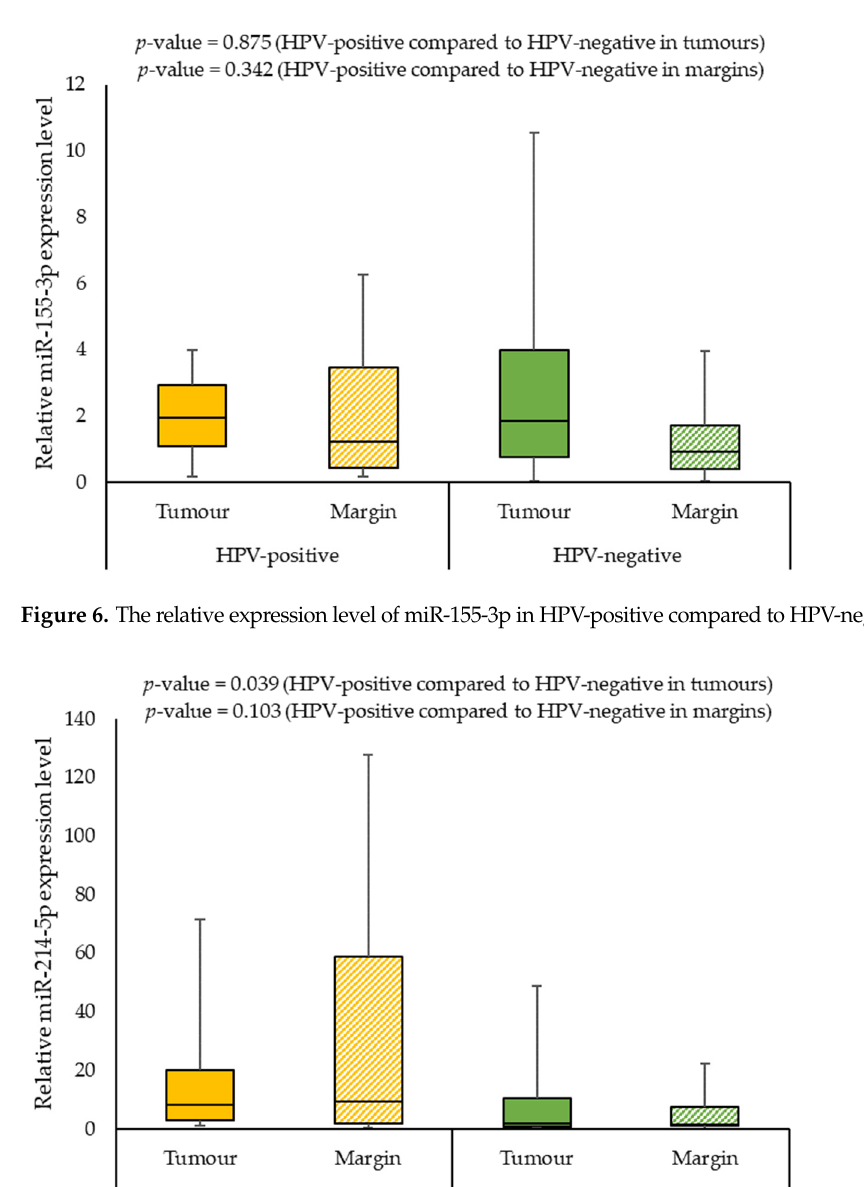
Figure 5. The relative expression level of miR-125b-5p in HPV-positive compared to HPV-negative patients.